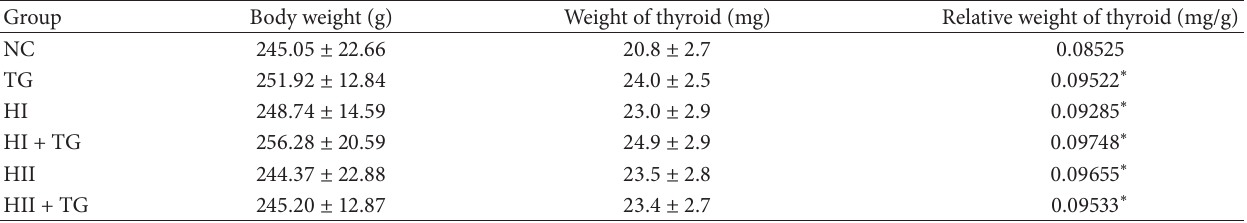
Table 2: Body weights and thyroid weights in model rats (mean ± SD).